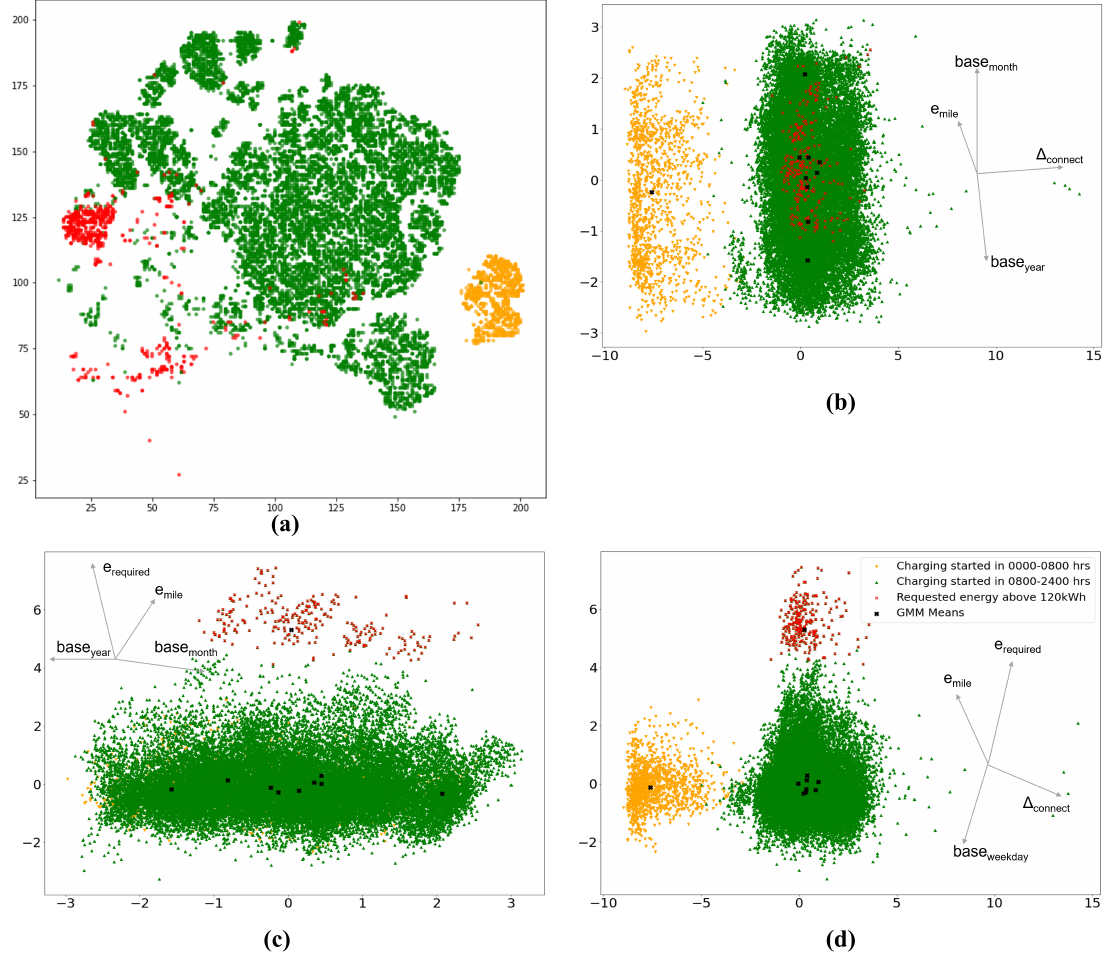
Figure 3. Demand profiling: learned projection from Hyperseed and subsequent analysis of this projection using PCA. Orange cluster: charging sessions started during 0000–0800 h. Green cluster: charging sessions started during 0800–2400 h. Red cluster: charging sessions with high energy consuming EVs. ( a ) Hyperseed learned projection. ( b ) PC1–PC2 projection of the dataset. ( c ) PC2– PC3 projection of the dataset. ( d ) PC1–PC3 projection of the dataset. Vector plots in ( b – d ) show the feature contributions to each of the